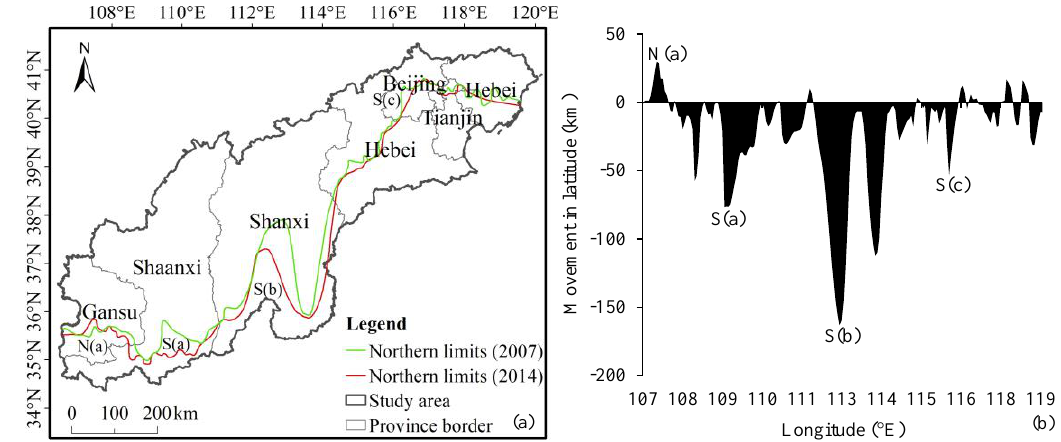
Figure 10. ( a ) Derived extent of the NLWW and ( b ) latitudinal movement of the NLWW during the period 2007–2014 (Red solid lines show NLWW at end of period, green solid lines show NLWW at beginning of period, black bars indicate latitudinal movement of NLWW, S(a, b, c) represent typical points of southward migration, and N(a) represents typical points of northward migration.).